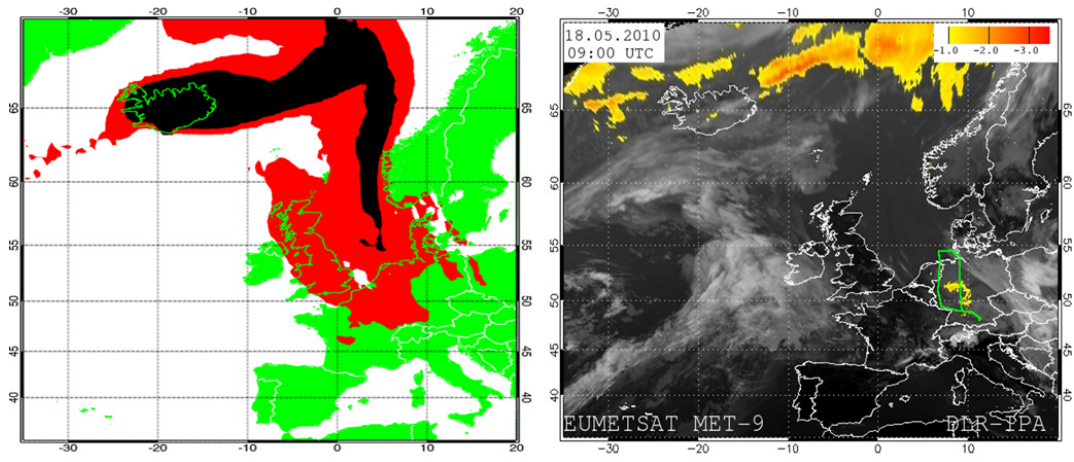
Fig. 18. VAAC prediction (issued at 06:00UTC 18 May 2010) and Meteosat VA analysis for 09:00UTC 18 May 2010, including the Falcon flight